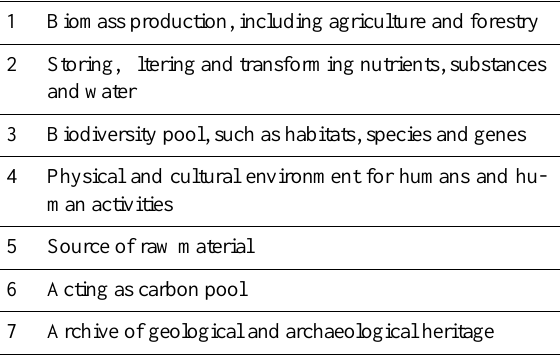
Table 3. The seven soil functions as defined by the European Com- mission